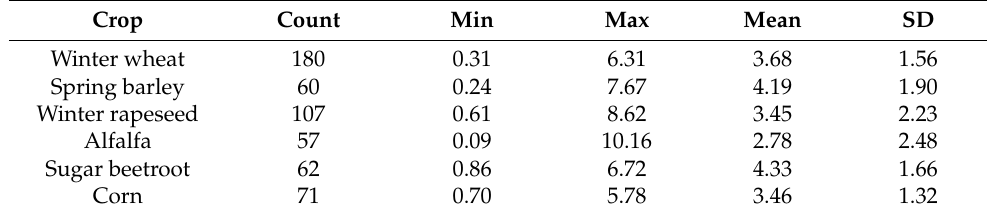
Table 1. Summary of LAI values measured in situ.